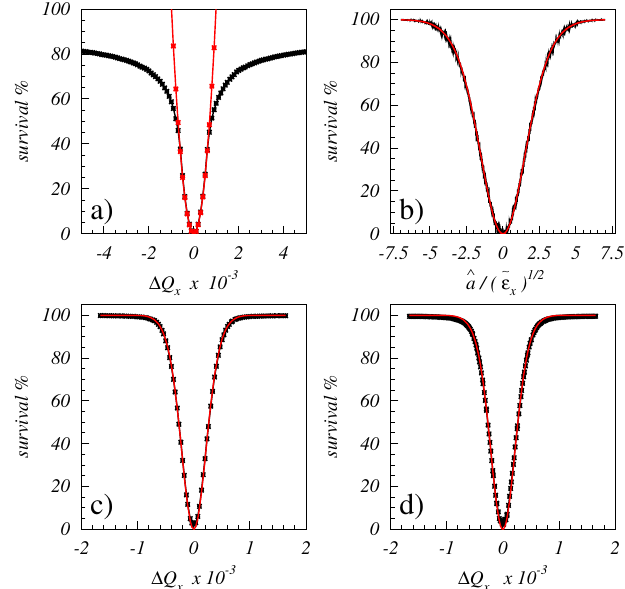
FIG. 21. (a) In black markers are plotting the tracking simu- lation results for a uniform beam distribution. In red markers are plotting the analytic results from Eq. (A3). At efficiency of 41% the fixed points intercept the acceptance. From there on the formula exhibits large discrepancy with respect to the numerical findings. (b) Beam survival for a 1D Gaussian beam distribution as a function of ^ a 2 = ~ (cid:3) x . (c) Beam survival for a 1D Gaussian beam distribution as a function of (cid:1) Q x (black), and theoretical prediction (red). (d) Beam survival for a 2D Gaussian beam distribution as function of (cid:1) Q x (black), and theoretical predic- tion for a 2D beam